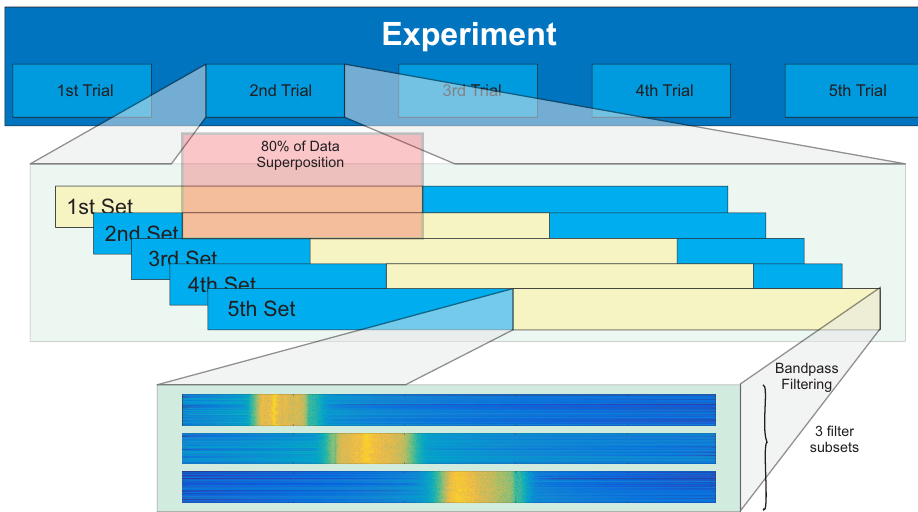
Figure 5. Schematic of the database for one